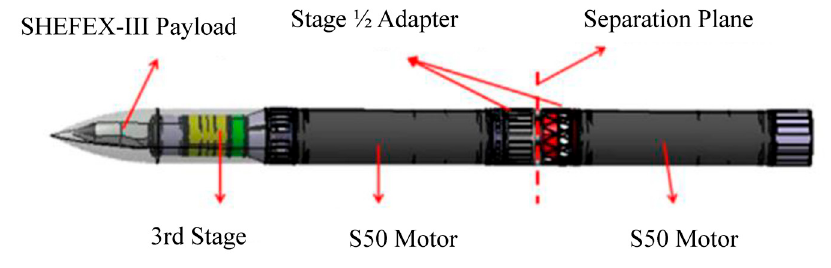
Figure 2. Schematic diagram of the rocket stages [2].